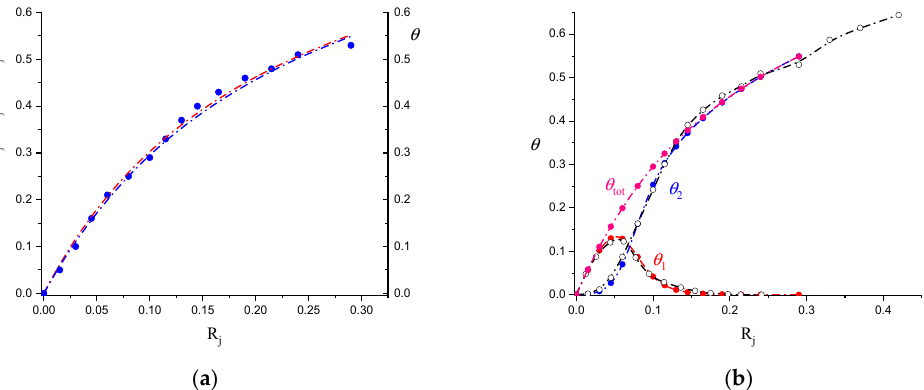
Figure 1. ( a ) Dependence of the absolute value of the “specific” change of the molar ellipticity of sodium pectate as a function of the calcium-to-polymer molar ratio R j . Blue full circles, experimental data (monomodal); blue dash-dotted curve, fitting curve with the present method; red dash-dotted curve, fitting with the Langmuir model. ( b ) Fractions of chemically bound calcium ions by sodium pectate as a function of the molar ratio R j calculated from the fitting of the CD data of panel ( a ). Red symbols, fractions of bonding mode 1, θ 1 , blue symbols, fractions of bonding mode 2, θ 2 . The open black circles and the dash-dotted black curves correspond to the values of the fractions for each type of bonding as calculated and reported in reference